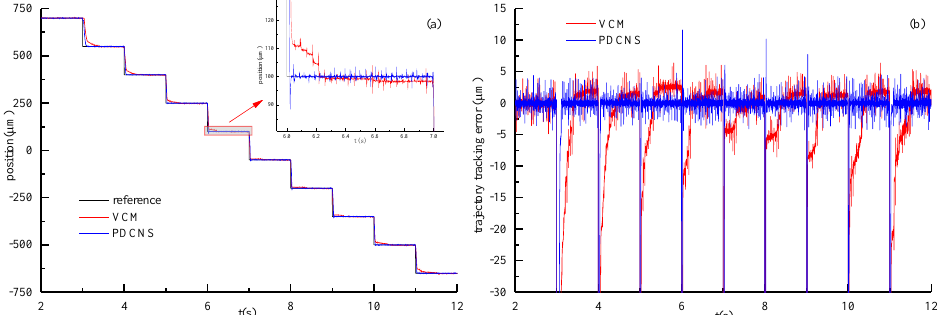
Figure 13. Consecutive-step trajectory (from 0.7 mm to − 0.65 mm with a step size of − 0.15 mm) control tests ( a ) tracking results and ( b ) tracking errors.